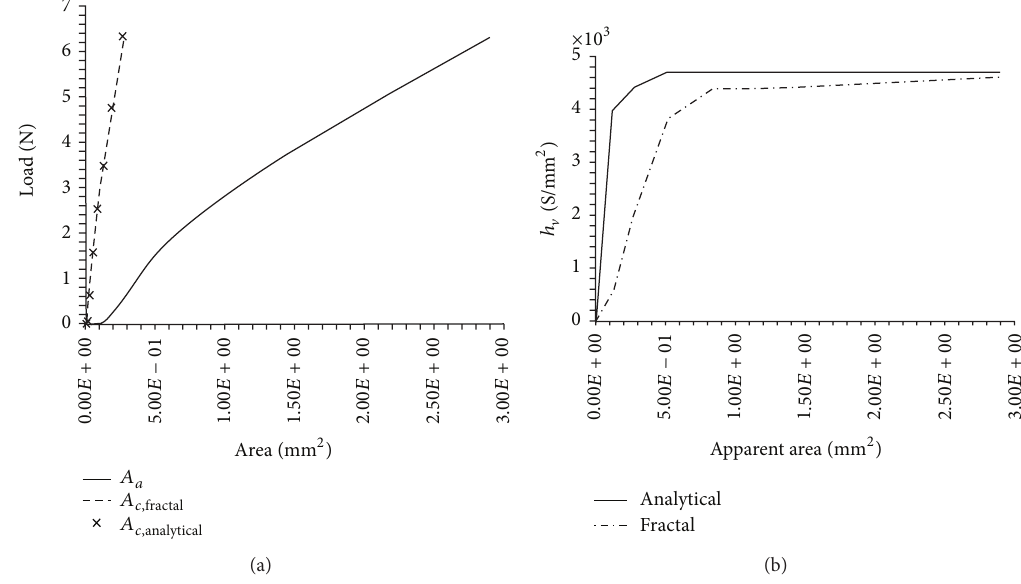
Figure 19: Apparent and real contact area at different load levels (20 ∘ C) (a); comparison between analytical and numerical electrical con- ductivities (b).